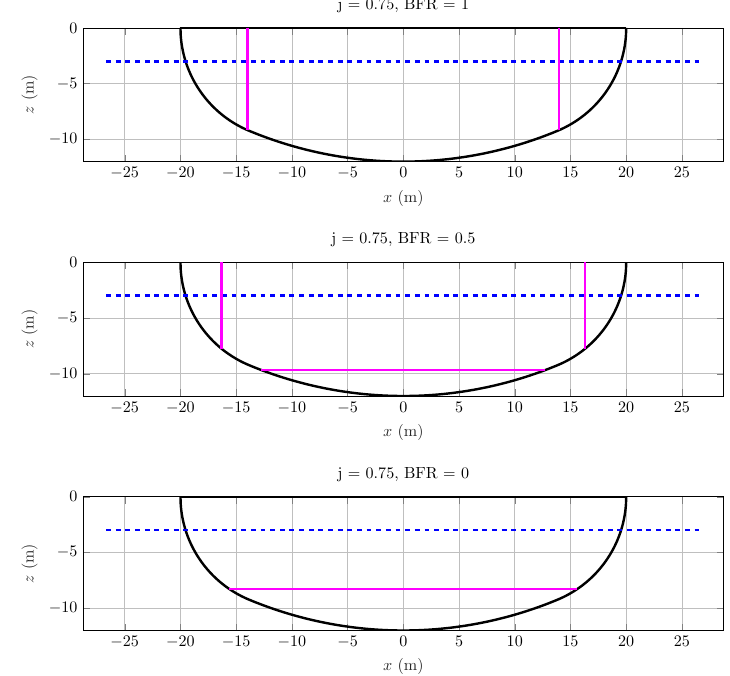
Figure 7. Examples of the effects of the j and ballast filling ratio (BFR) design